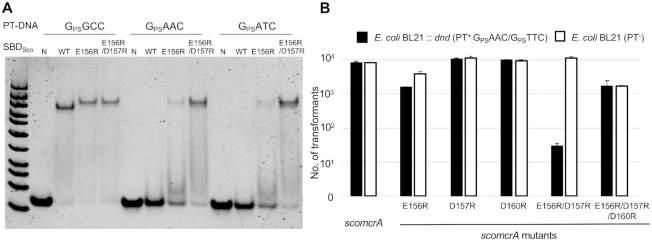
Sequence specificity of ScoMcrA mutants. (A) Ability of SBDSco mutants to bind GPSGCC, GPSATC and GPSAAC in EMSAs. N, no protein added to the EMSA; WT, the wild-type SBDSco; E156R, SBDSco–E156R mutant; E156R/D157R, SBDSco–E156R/D157R mutant. (B) Uptake efficiency of scoMcrA and its mutants by the PT− host and PT+ host. The PT+ host contains the expression vector with the dnd gene cluster from Salmonella enterica, which encodes the ‘writer’ proteins for phosphorothioation of GPSAAC /GPSTTC. Transformation efficiency obtained with the dnd host (PT+) and the negative control host (PT−) is indicated by black bars and white bars, respectively.